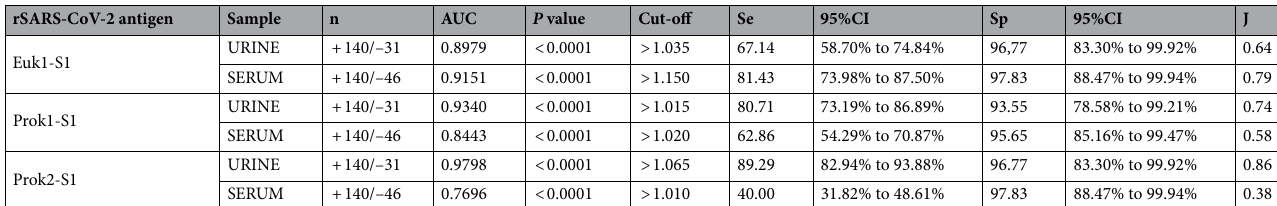
Table 1. Comparative table of the results obtained from the diagnostic test for COVID-19 based on the search for specific IgG antibodies in urine and serum. Samples from symptomatic patients for Covid-19 and with PCR + for SARS-COV-2, as well as from healthy individuals pre-exposed to the virus were used. The individual index (I) value obtained by the Abs / cut-off ratio were used to construct ROC curves. The diagnostic performance of the antigen in relation to the type of sample used was based on the evaluation of sensitivity (95% CI), specificity (95% CI), area on the curve (AUC) and Youden index (J). Legend: J = (Se + Sp)–1; n = samples number, + = positive sample, − = negative sample.